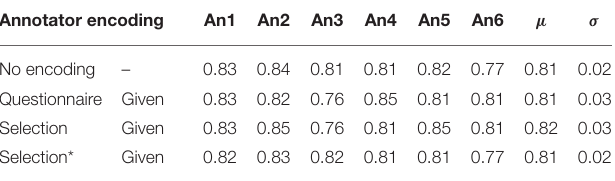
TABLE 12 | Cross-validation performances on the unaggregated test sets after training on the aggregated training sets. Annotator